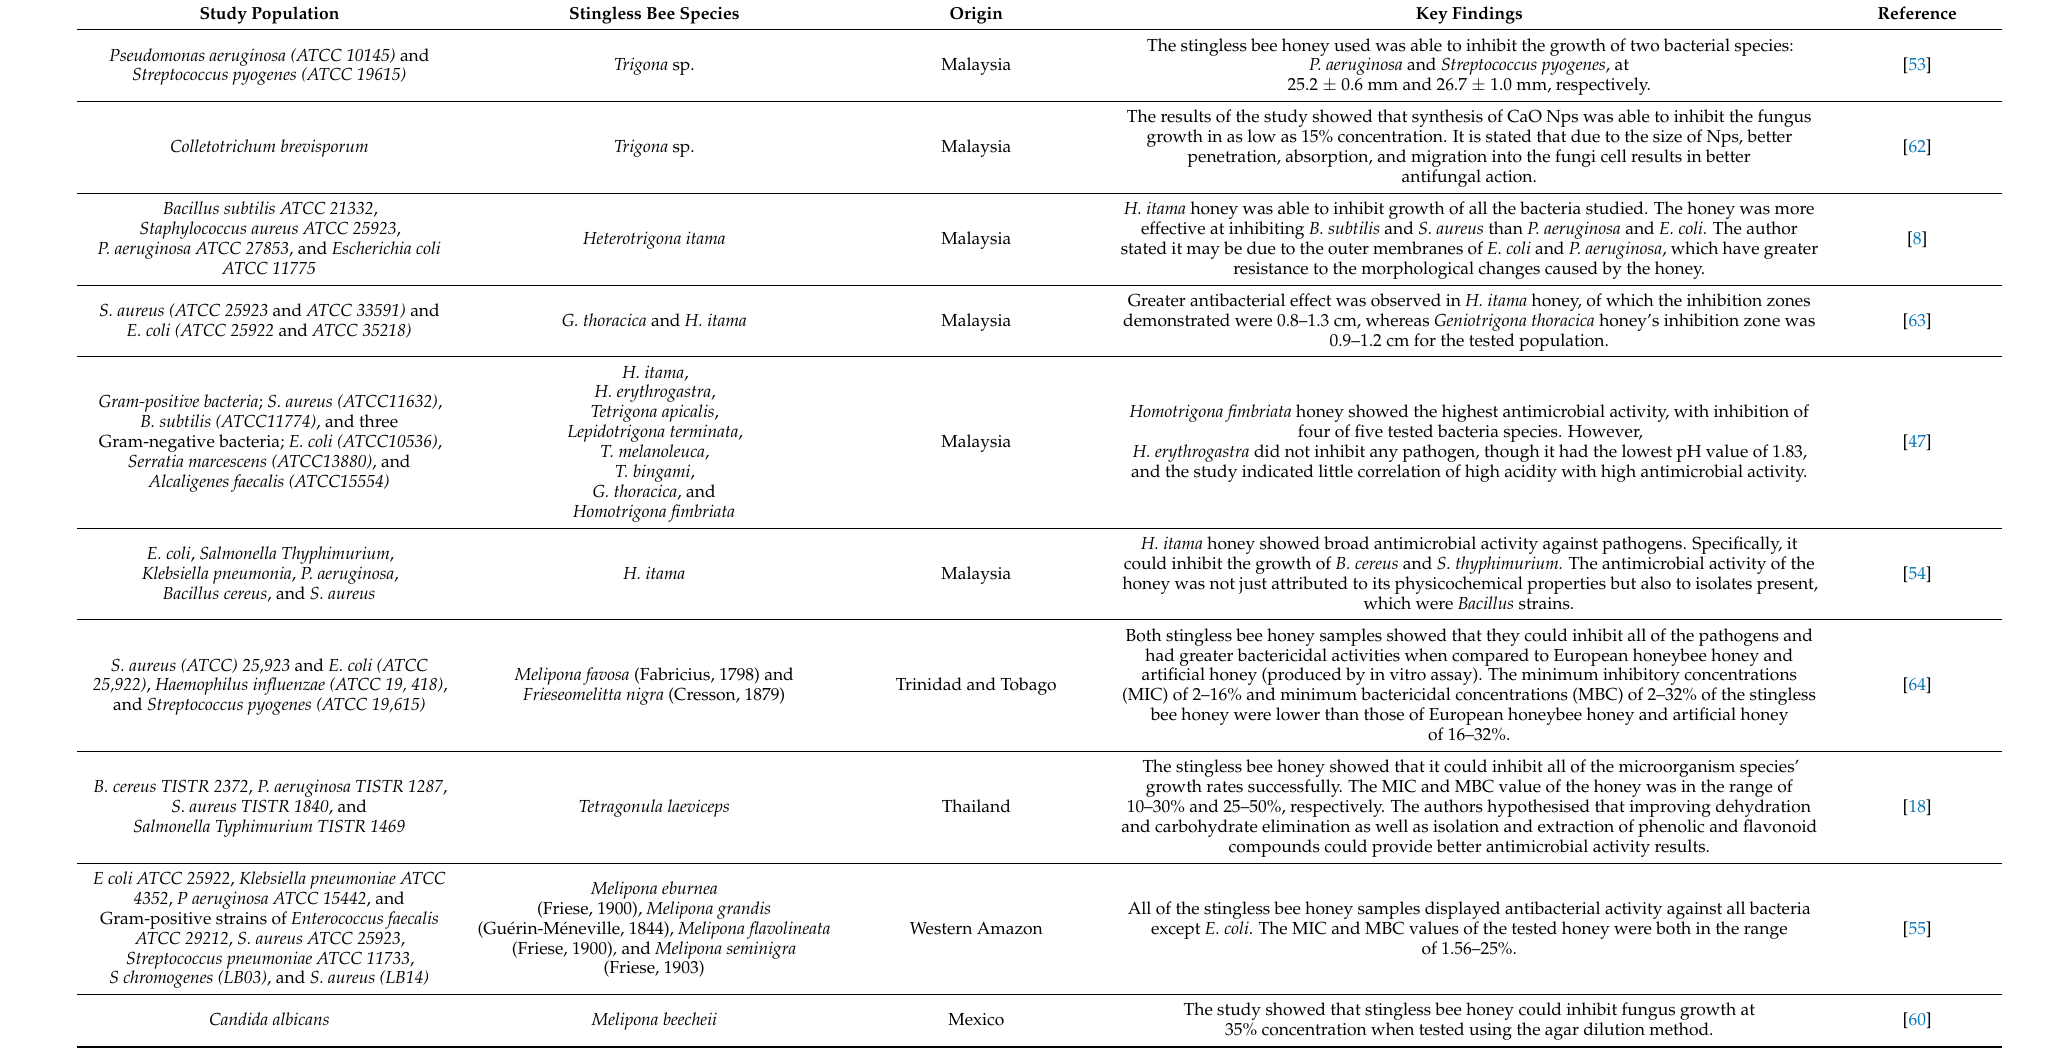
Table 3. Antimicrobial activity of stingless bee